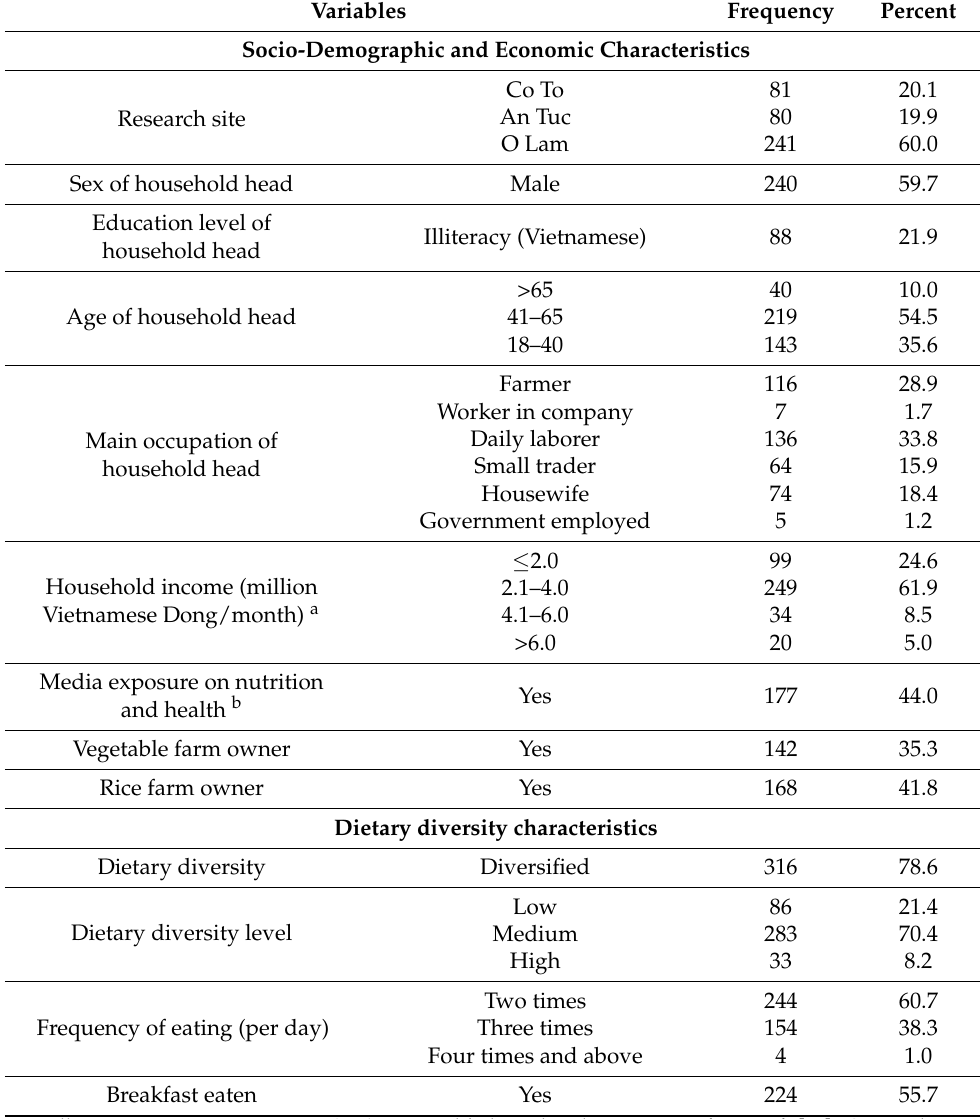
Table 1. Socio-demographic, economic, and dietary diversity characteristics of respondents (n = 402).